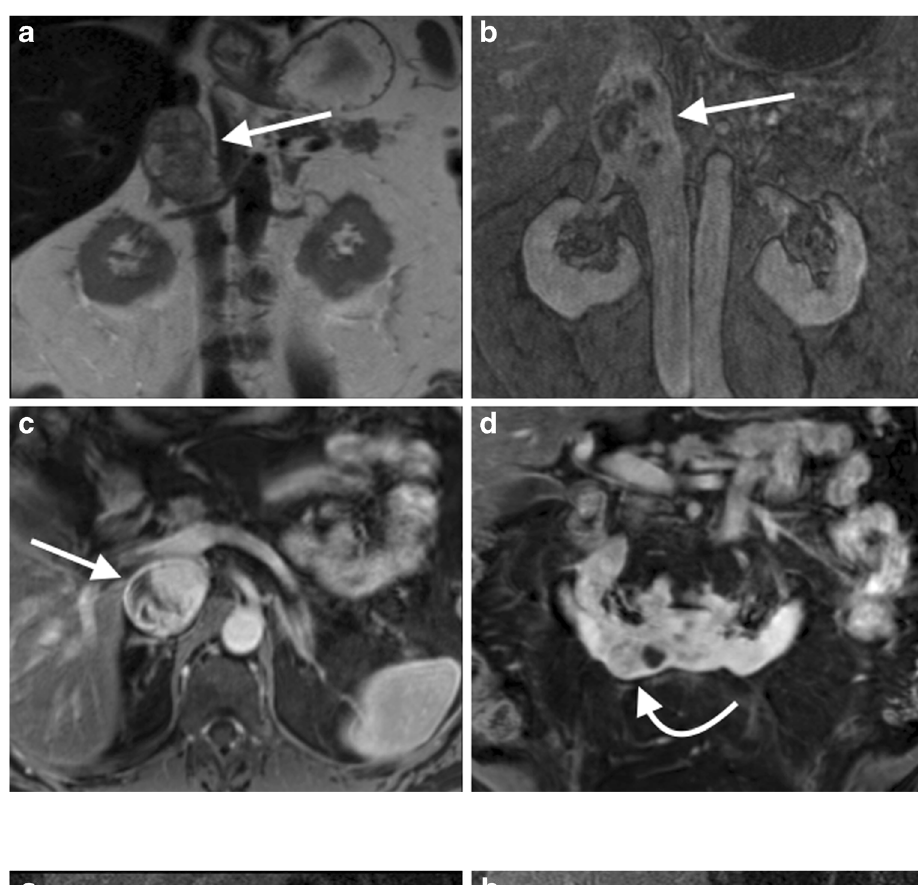
Fig. 14 A 35-year-old woman underwent an abdominal MR venogram 5 days post dilatation and curettage for an intrauterine fetal death at 25 weeks. Coronal images from a post-contrast ve- nous phase fat saturated T1 se- quence of the abdomen demon- strates the post-partum uterus ( a , curved arrow ), with marked dila- tation of the right ( b , arrow ) and left ( c , arrow ) gonadal veins with central filling defects consistent with bilateral gonadal vein thrombosis. The thrombus ex- tends up to the juxtarenal IVC ( c , curved arrow ). Axial image from a T1 post-contrast venous phase fat saturated T1 sequence of the abdomen ( d ) demonstrates the expanded gonadal veins bilateral- ly with central filling